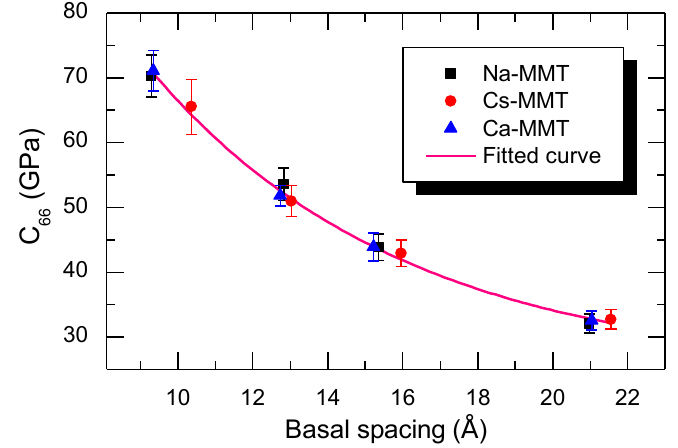
Figure 9. The C 66 elastic constant as a function of basal layer spacing. Young’s moduli of the different MMT systems under various hydration can be obtained by further conversion of the stiffness tensor, and the variation of Young’s moduli with basal spacing is shown in Figure 10. The in-plane Young’s moduli E 1 and E 2 are consistent with C 11 and C 12 that decrease nonlinearly with the increase of water content. For the Young’s modulus of E 3 which is perpendicular to the mineral plane, its value for the dry MMT system is 2–3 times that of the hydrated system for Na-MMT and Ca-MMT. E 3 of the hydrated MMT system also decreases nonlinearly with the increase of water content. Interestingly, for Cs-MMT, the Young’s modulus, E 3 , of different hydrated MMT systems, even dry MMT systems, is almost the same. Preliminary analysis shows that this may be related to the larger radius of Cs + ions. For the dry MMT system, the interlayer spacing is large, which induces a low compression strength. After hydration, the Cs + ions always form an inner-sphere complex, which has little effect on the strength, thus making all